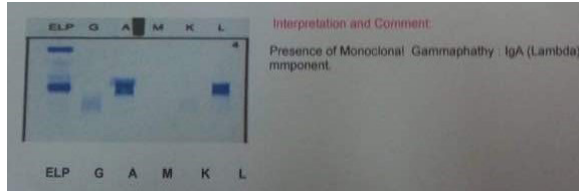
Figure 2. Serum immune fixation indicating monoclonal gammopathy (IgA Lambda).